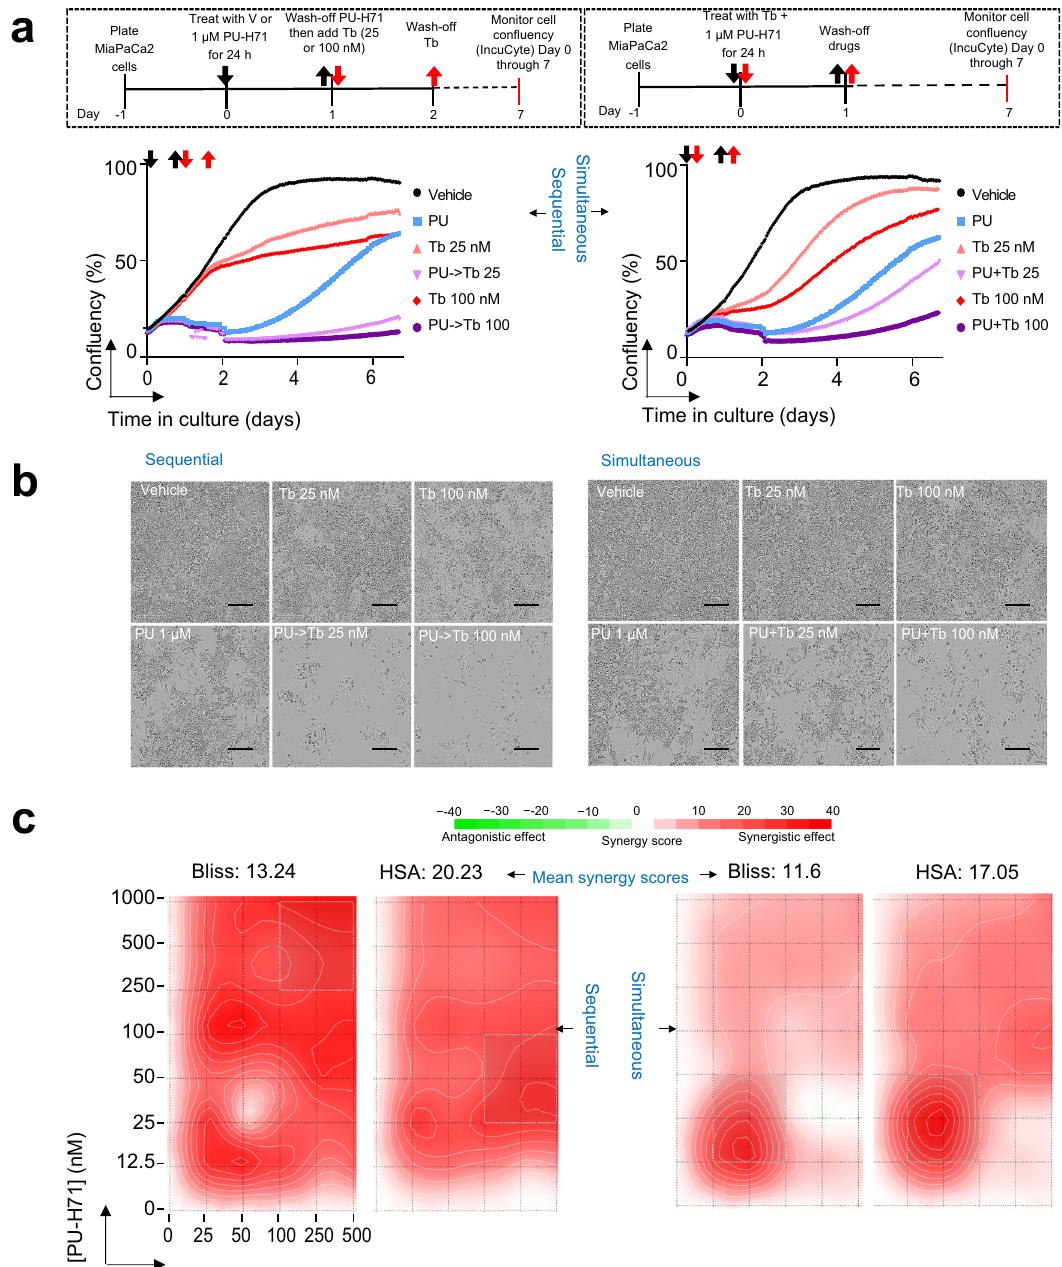
Fig. 7 Comparison of sequential and simultaneous drug addition paradigms. a Cell con fl uency monitored by live-cell microscopy under the treatment paradigm as shown in schematics. PU, PU-H71 at 1 µ M; Tb 25 and Tb 100, trametinib at 25 nM and 100 nM, respectively. Each curve represents the mean of three biological replicates from three and four independent experiments for simultaneous and sequential treatment, respectively. b Micrographs are representative of each experimental condition from ( a ). Images were taken at day 7. Scale bar, 300 µ m. c Synergy analysis for the drug paradigms shown in panel ( a ). ATP levels were measured at day 3 as a surrogate of cell viability. Synergy scores were calculated using the SynergyFinder web-application using two synergy scoring models. Bliss independence principle is appropriate when two drugs are mutually nonexclusive, i.e. when each targets a different pathway. The highest Single Agent (HSA) states that the expected combination effect equals to the higher effect of individual